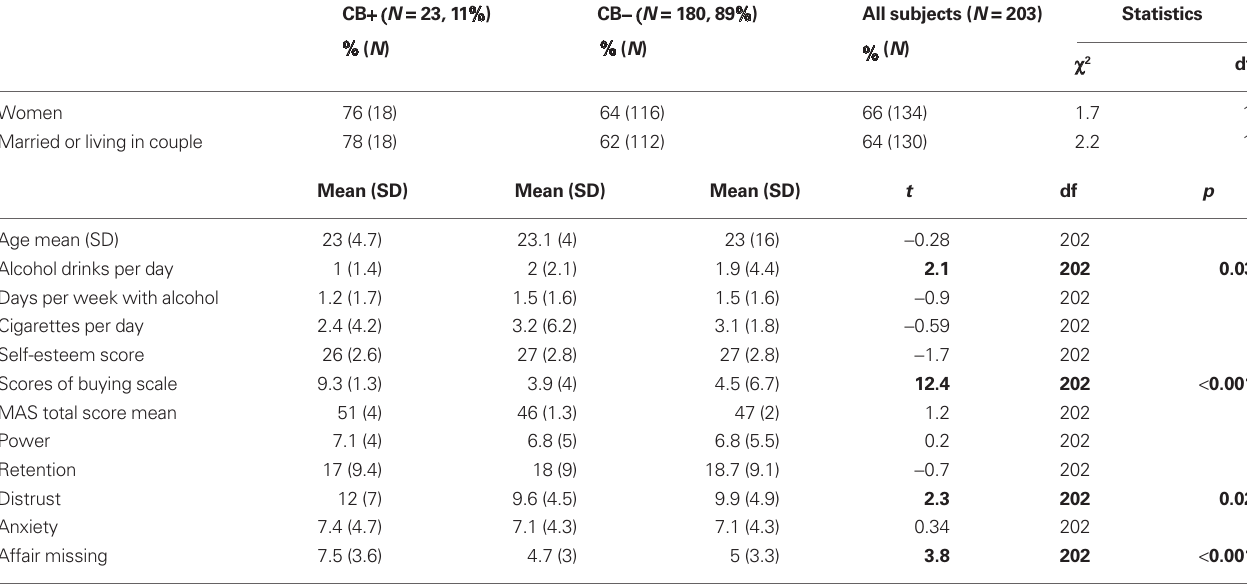
Table 1 | Comparison of students presenting with (CB + ) or without (CB − ) compulsive buying.